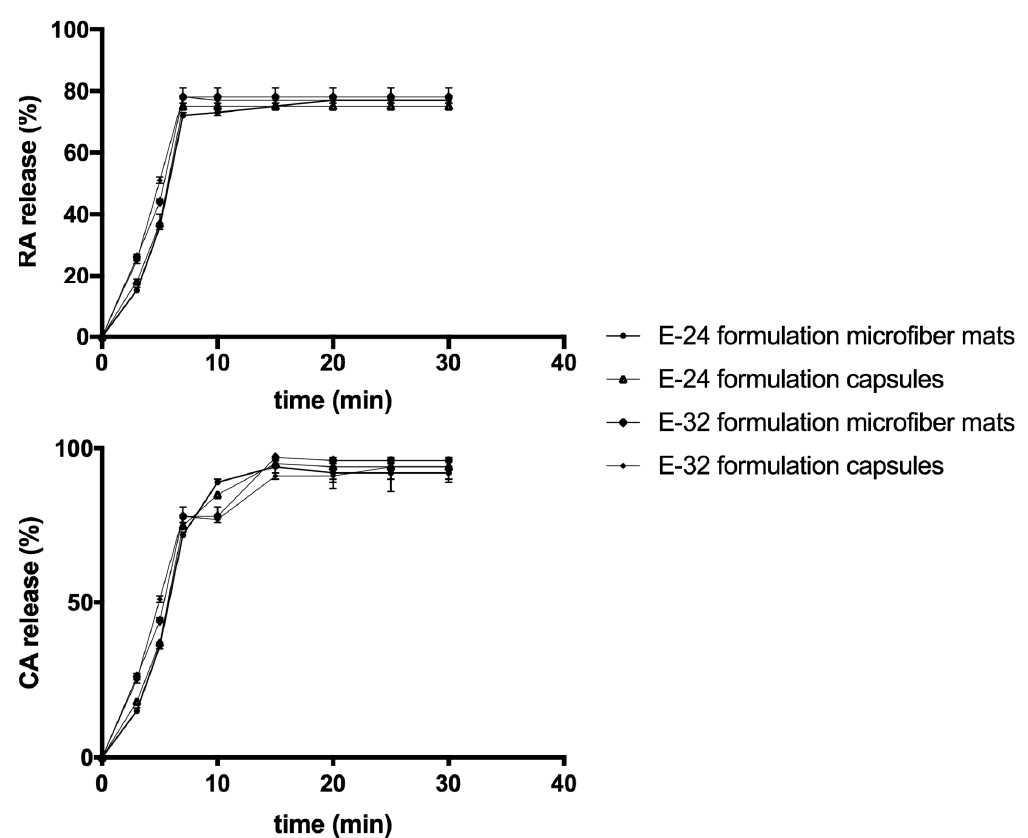
Figure 3. Release of rosmarinic acid and carvacrol from E-24 and E-32 nano-microfibers mats and E-24 and E-32 formulation capsules in vitro. and E-32 formulation capsules in